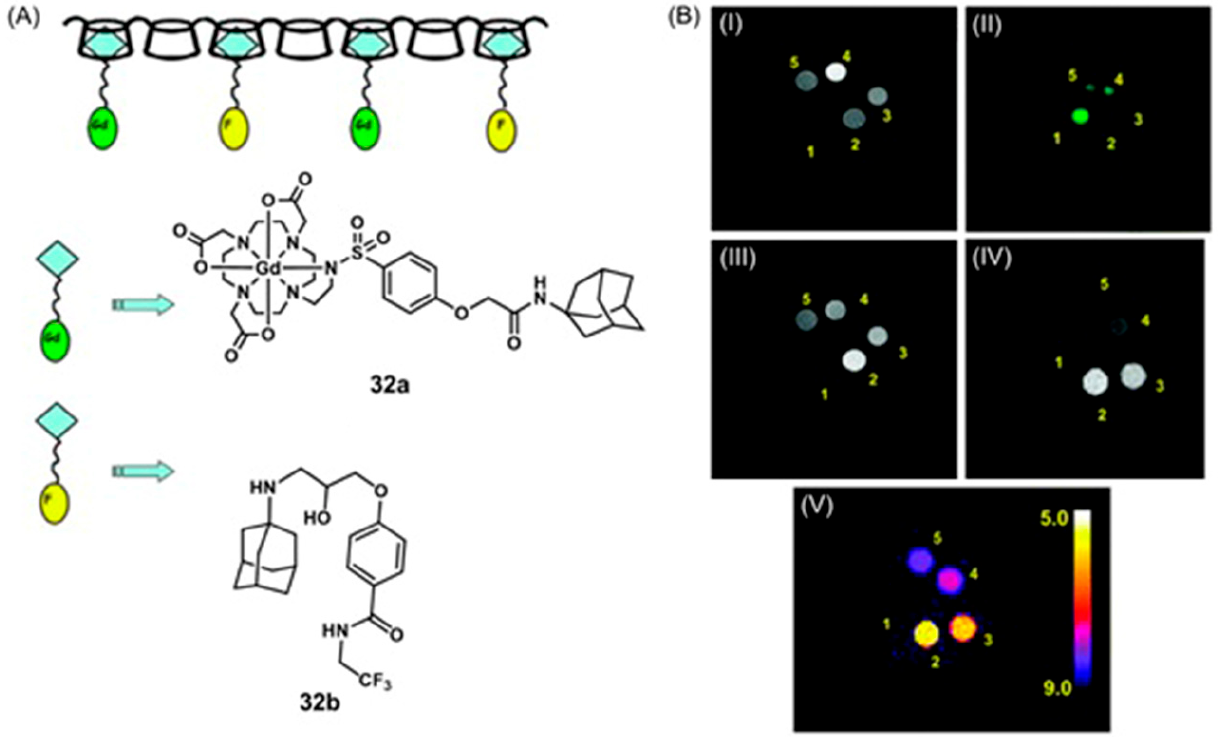
Figure 66. ( A ) Schematic representation of the supramolecular adduct between poly- β -cyclodextrin, Gd III -containing complex, 32a , and the 19 F-reporting molecule 32b designed for pH mapping. ( B ) MRI images of solutions of (1) NaPF 6 (25 mM); (2) poly-cyclodextrin (10 mM); 32b (2.5 mM); 32a (0.5 mM) at pH = 6.8; (3) poly-cyclodextrin (13 mM); 32b (3.25 mM); 32a (0.65 mM) at pH = 7.2; (4) poly-cyclodextrin (30 mM); 32b (7.5 mM); 32a (1.5 mM) at pH = 7.6; (5) poly-cyclodextrin (20 mM): 32b (5 mM); 32a (1 mM) at pH = 8.2. (I) T 1 -weighted spin-echo 1 H-MR image acquired at 7.1 T (TR = 80, TE = 4.4, NEX = 32, 1 slice, 1 mm); (II) T 1 -weighted spin-echo 19 F-MRI acquired at 7.1 T (TR = 2000, TE = 1.4, NEX = 384, 1 slice, 3 mm); (III) T 1 -weighted spin-echo 1 H-MR image acquired at 7.1 T and normalized to the concentrations found from image (II); (IV) T 1 -weighted spin-echo 1 H-MR image acquired at 1 T (TR = 80, TE = 7.2, NEX = 32), 1 slice, 2 mm) and normalized to the concentrations found from image (II); (V) pH-map image derived from image (IV). Adapted with permission of the Royal Society of Chemistry, from Poly- β -cyclodextrin based platform for pH mapping via a ratiometric 19 F/ 1 H MRI method. Gianolio, E.; Napolitano, R.; Fedeli, F.; Arena, F.; Aime, S. 40 , 2009 ; permission conveyed through Copyright Clearance Center, Inc. [394].